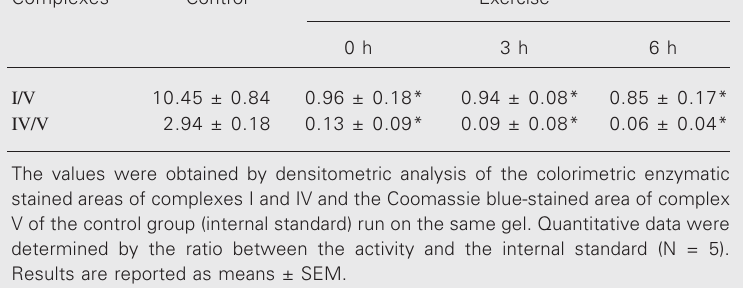
Table 4. Activity ratios of complexes I and IV in soleus muscle after exhaustive physical exercise.